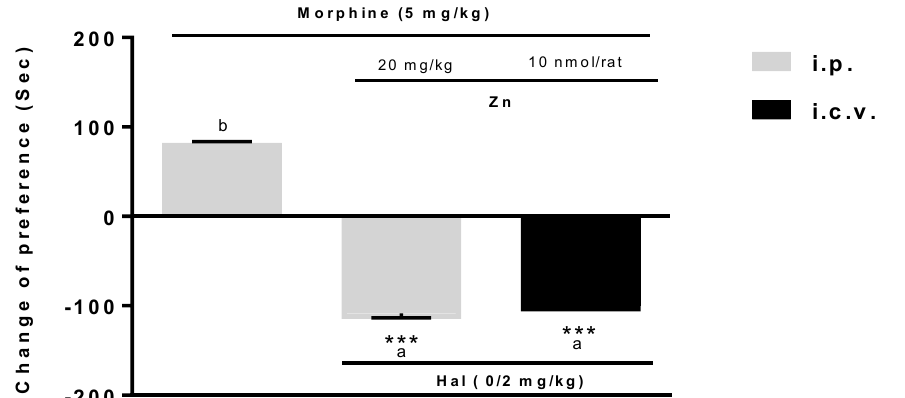
Figure 6. Effect of haloperidol on the enhancement effect of Zn on the expression of morphine-induced CPP. Zn was given i.p. (20 mg/kg) and i.c.v. (10 nmol/rat) separately after the haloperidol treatment in the post-conditioning sections. Each point represents the mean± SEM of < six rats. *** Presents significant between saline (10 ml/kg, i.p.) group at P < 0.001. Different letters indicate significant differences between the mean± SEM of six rats. *** Presents significant between saline (10ml/kg, i.p(cid:484)(cid:524)(cid:3) (cid:137)(cid:148)(cid:145)(cid:151)(cid:146)(cid:3) (cid:131)(cid:150)(cid:3) (cid:19) groups (p<0.05) (Tukey’s post-hoc test). Zn=Zinc and Hal=